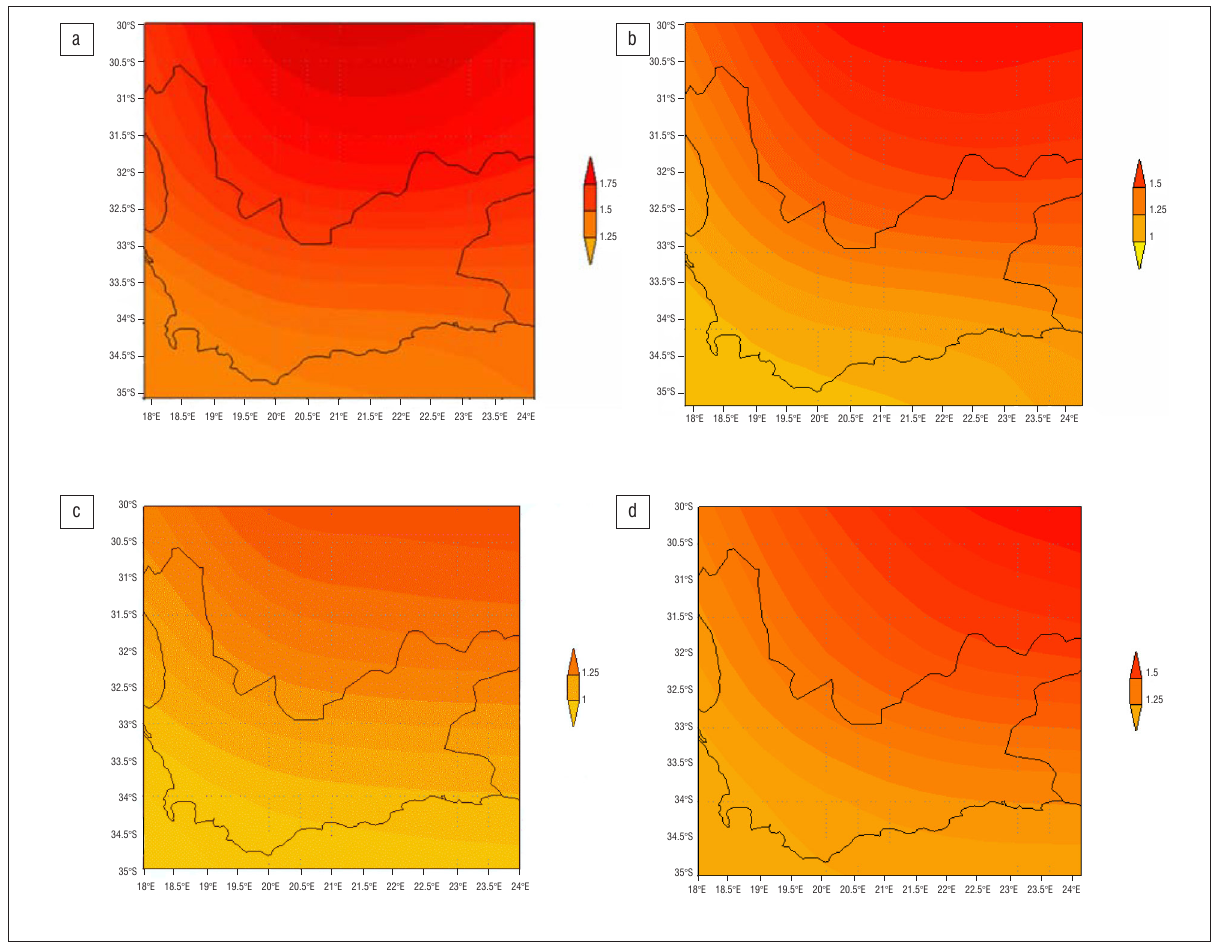
Figure 1: Projected temperature anomalies for the Western Cape, South Africa: (a) December–February, (b) March–May, (c) June–August and (d) September–